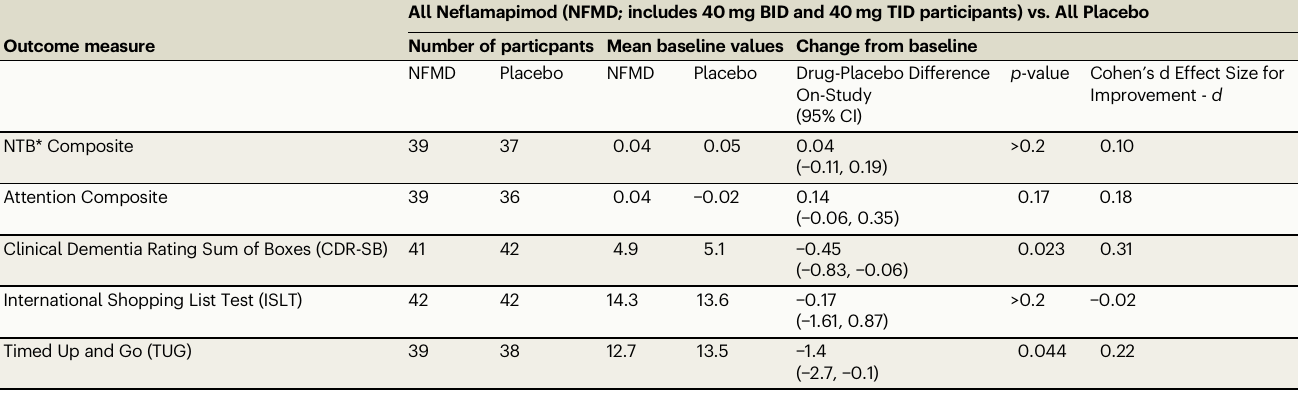
Table 2 | Ef fi cacy outcome measures in the clinical